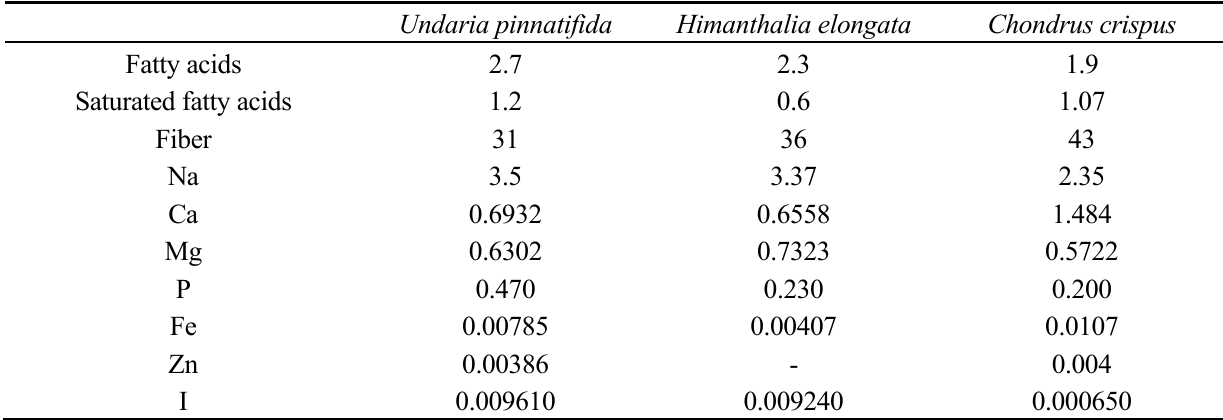
Table 1. Major elements and composition (in wt %) of three marine